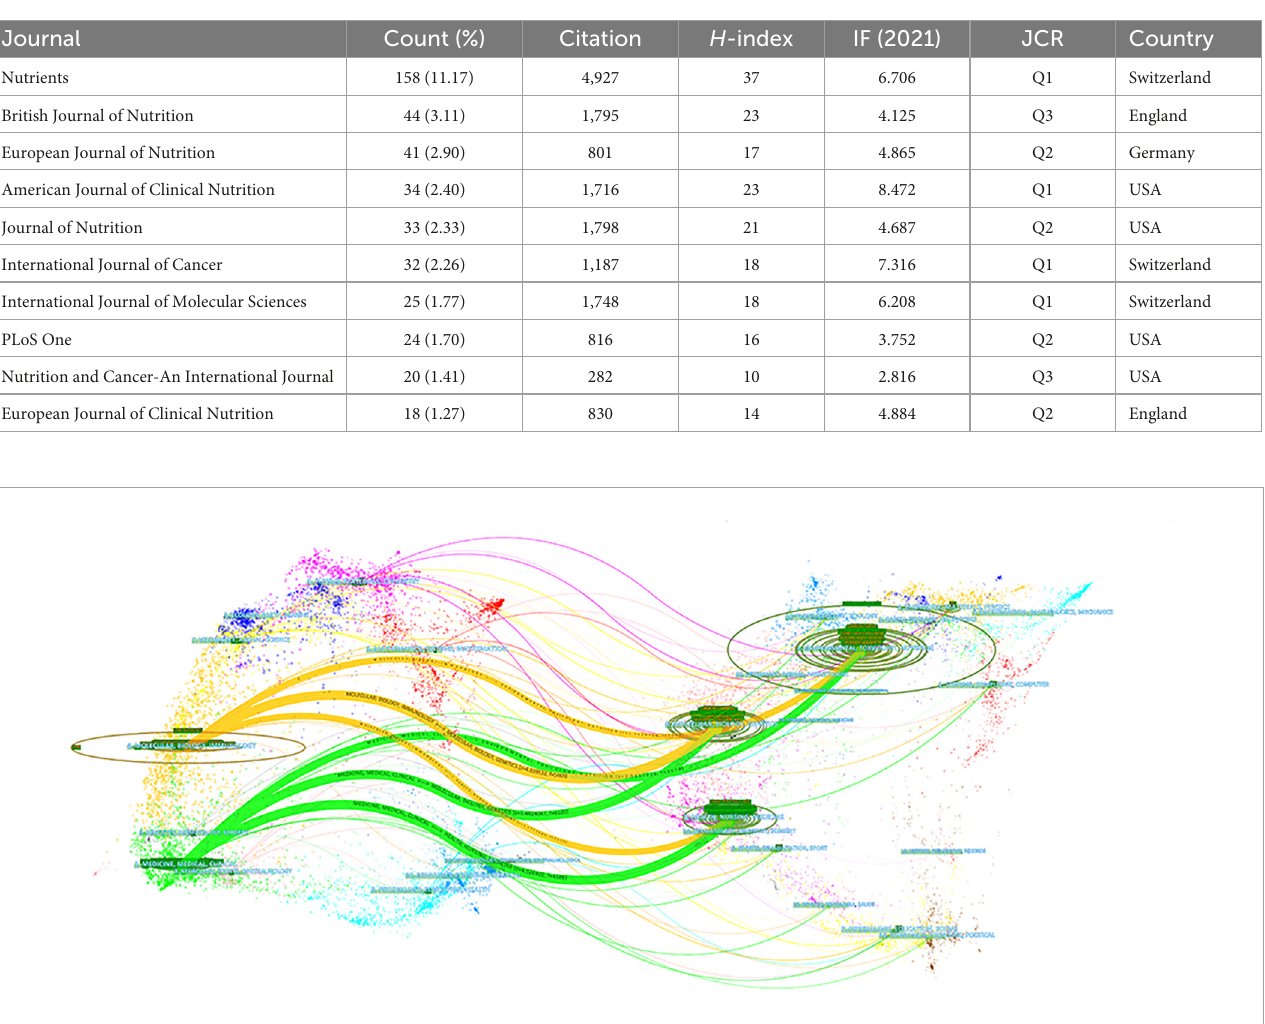
Carlo La Vecchia (0.50) and Antonia Trichopoulou (0.49).